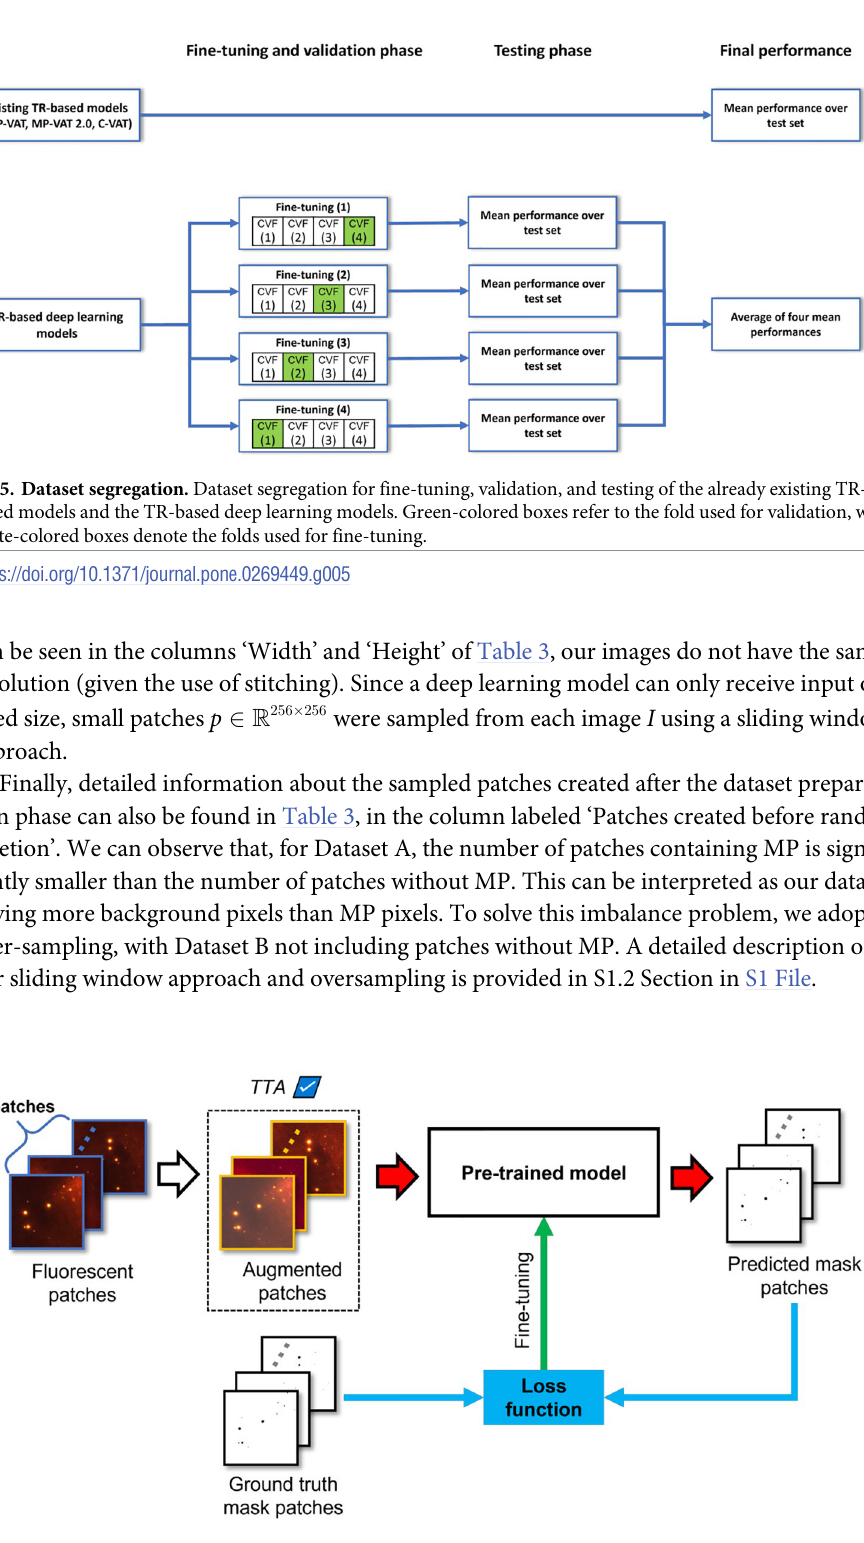
Fig 6. Fine-tuning of a TR-based deep learning model. N corresponds to the size of the mini-batch of images fed to the model. The dotted box represents an additional step that is performed when TTA is included.